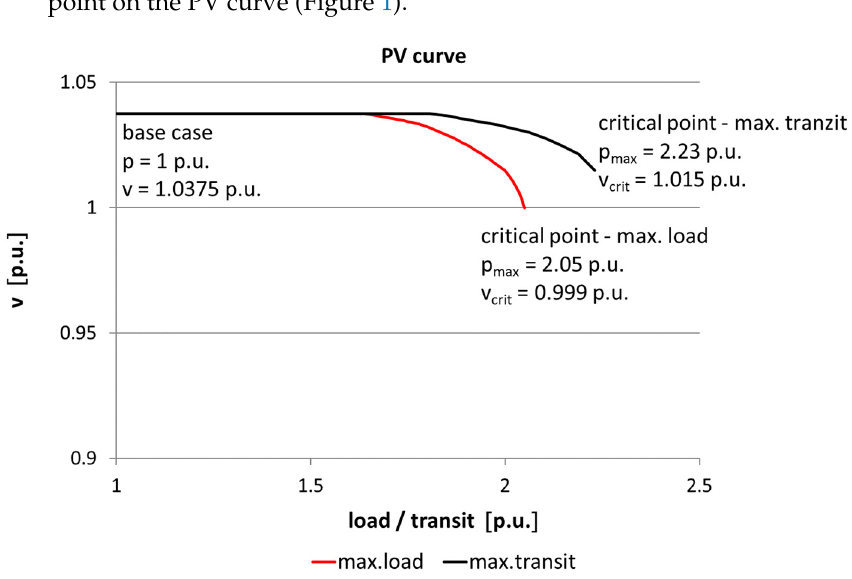
Figure 1. PV curve (of the node) example and explanation. An example of the PV curve with a marked base case and two critical points for the worst cases, max. load and max. transit, is shown in Figure 1. Voltage and transit values are expressed as per ‐ unit values. Voltage is related to the nominal voltage level of 400 kV, i.e., 1 p.u. = 400 kV. Transit is related to the transit value through the PS SR in the base case of 2216.2 MW (winter)/626.2 MW (summer), i.e., 1 p.u. = transit in the